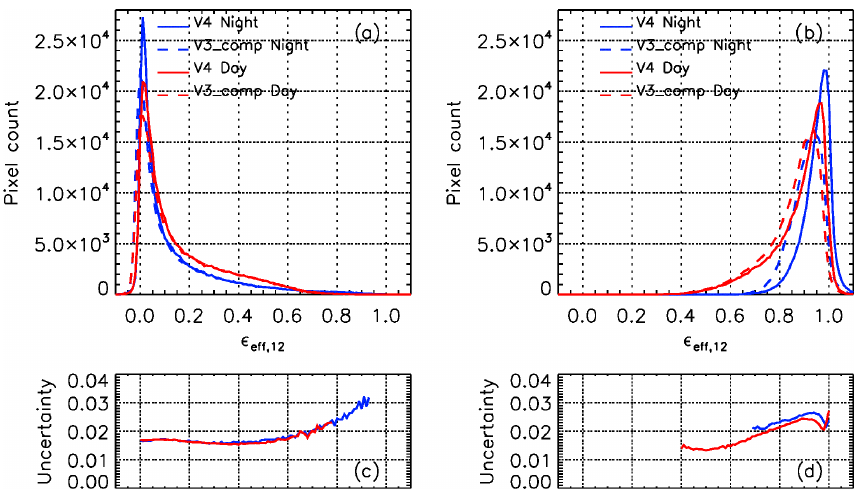
Figure 2. Effective emissivity distributions at 12.05µm in (a) ST and (b) opaque single-layered ice clouds over oceans between 60 ◦ S and 60 ◦ N in January 2008 in V4 (solid lines) and in V3_comp (dashed lines). The blue and red curves are for nighttime and daytime data, respectively. Panels (c) and (d) are the V4 median random uncertainty estimates corresponding to panels (a) and (b) , respectively. Table 3. Inter-channel effective emissivity differences at ε eff , 12 ∼ 0 for retrievals in single-layered ST ice clouds over oceans between 60 ◦ S and 60 ◦ N in January 2008. N/A stands for “not